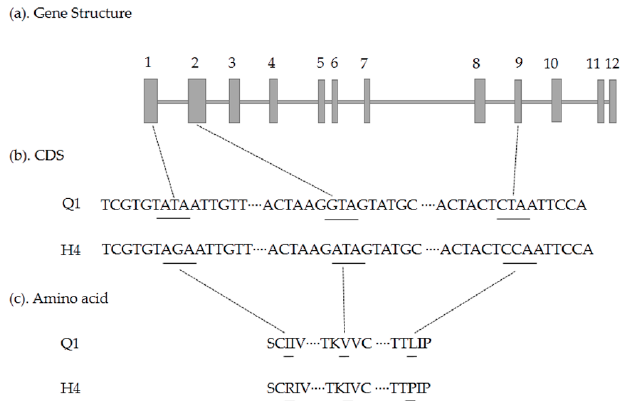
Figure 7. Comparison analysis of the cDNA sequence and amino acid sequence of the Csa3G904080 gene between Q1 and H4; a 3-bp mutation resulted in three amino acid mutations: ( a ) gene structure of Csa3G904080 , including twelve exons and eleven introns; ( b ) coding sequence analysis of three SNP mutations; ( c ) three amino acids mutation due to three SNP mutations.